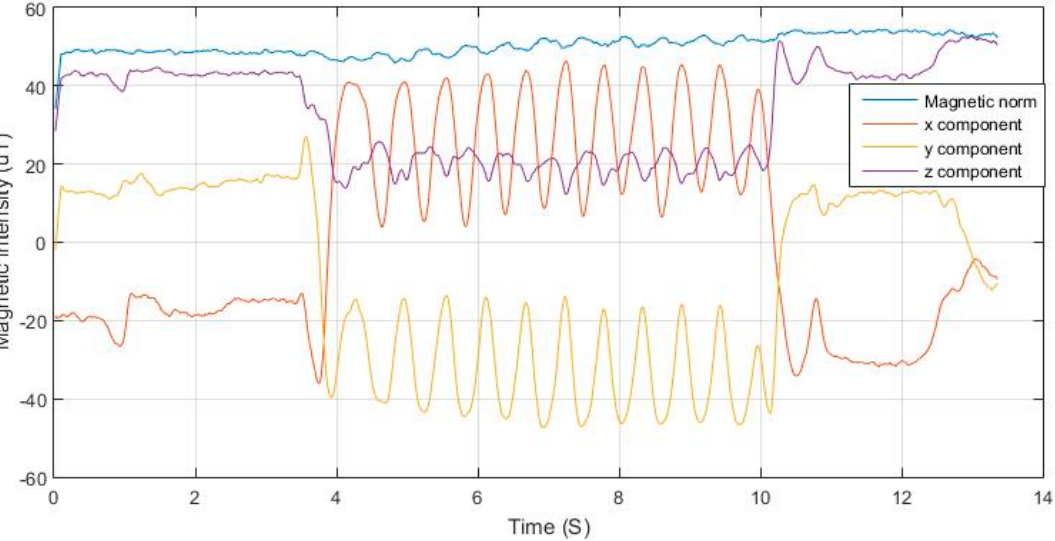
Figure 12. Magnetometer orientation change for a constant magnetic field and corresponding components change.